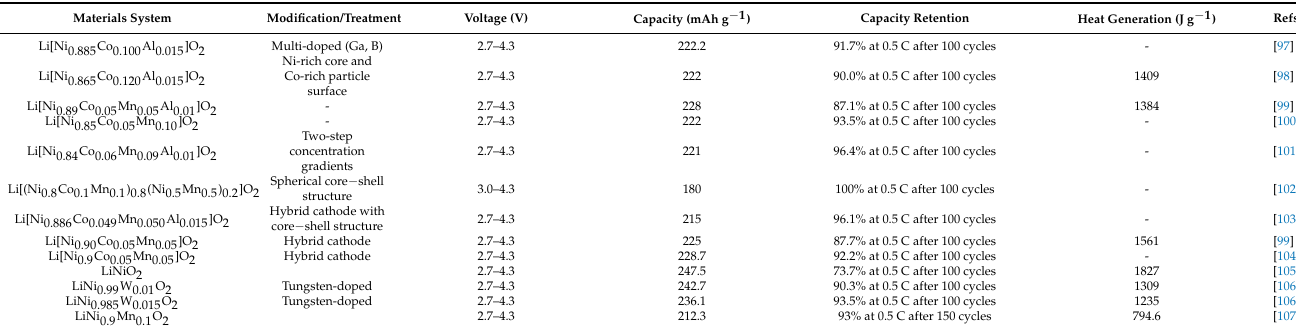
Table 1. Summary of the Ni-rich Co-less cathode materials and their electrochemical performance.